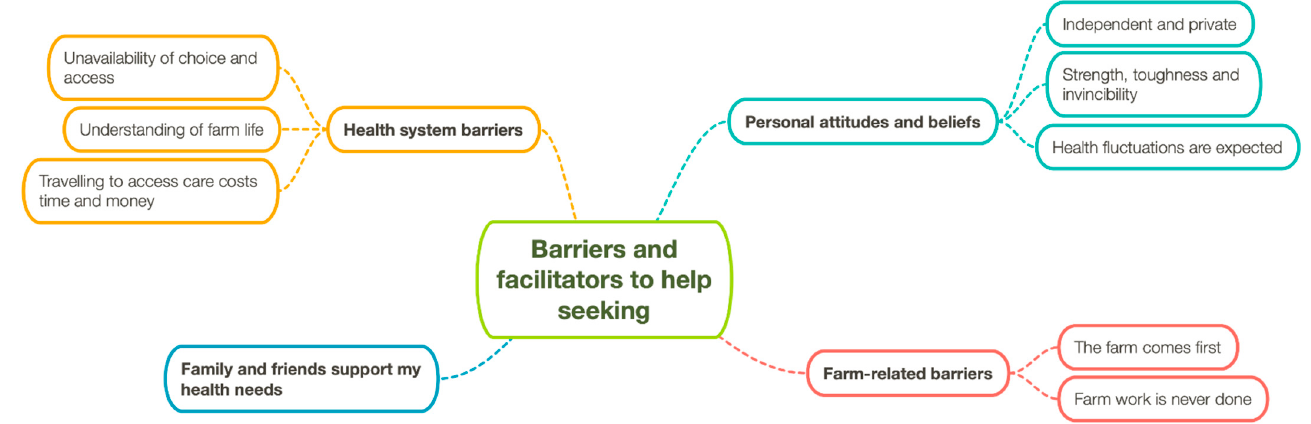
Figure 1. Thematic network diagram representing overarching themes and subthemes.